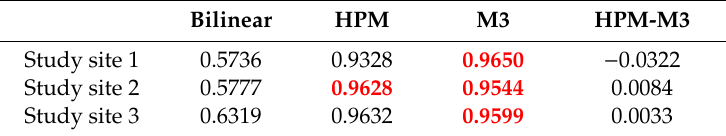
Table 3. Study site Q 2 n values derived considering the four Sentinel-2 10 m sharpened bands (Table 1) together ( n = 4). The highest Q 2 n value (least distortion) for each study site is shown in red bold font, and if values are within two decimal places (i.e., | HPM-M3 | < 0.01), then both are shown in red bold.